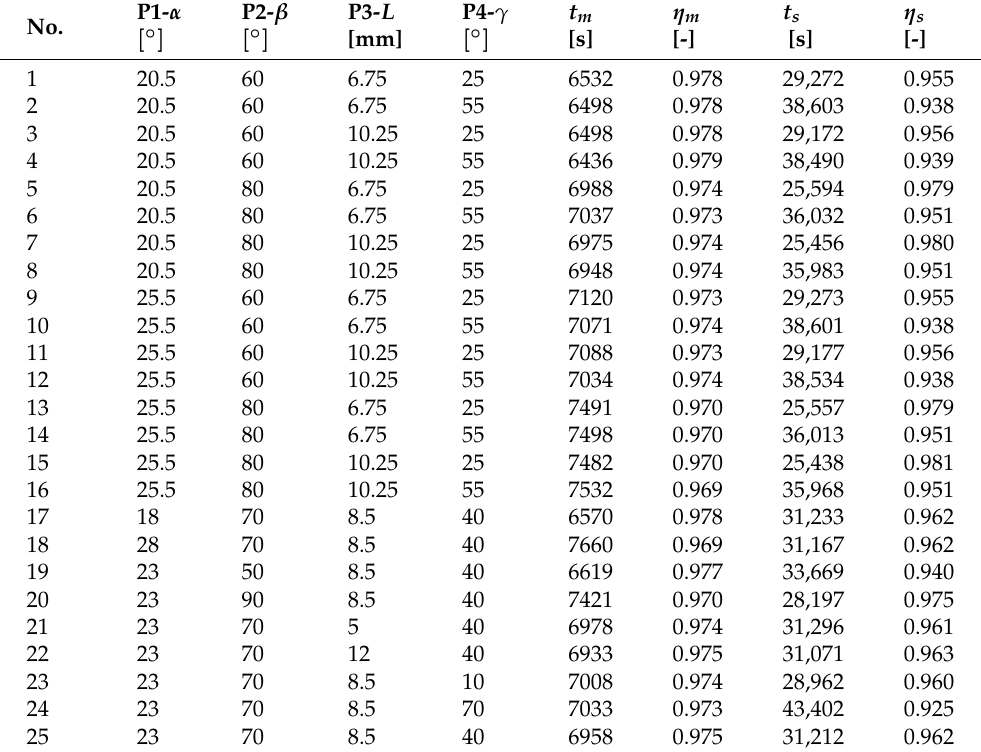
Table 4. The results of the simulation